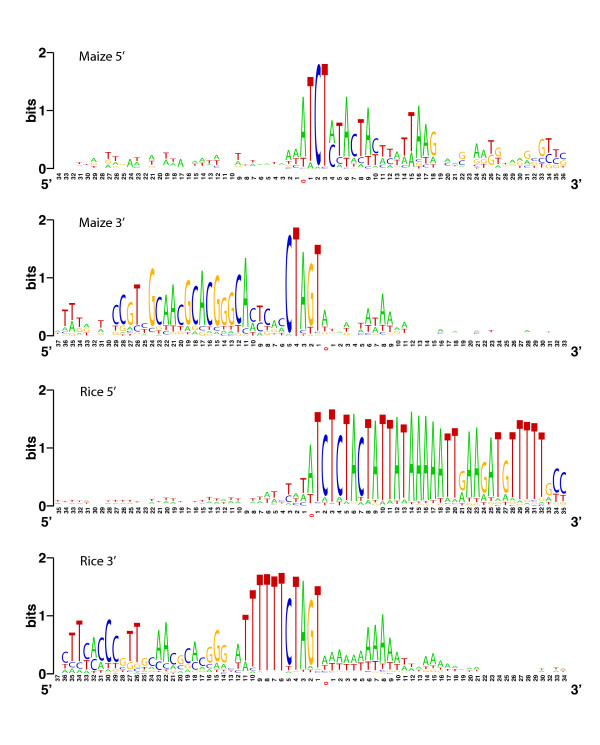
Conserved sequence properties of helitron ends. The height of the letter reflects the nucleotide conservation [36]. The x-axis represents nucleotide position; the nucleotide labeled as position '0' is the flanking nucleotide.